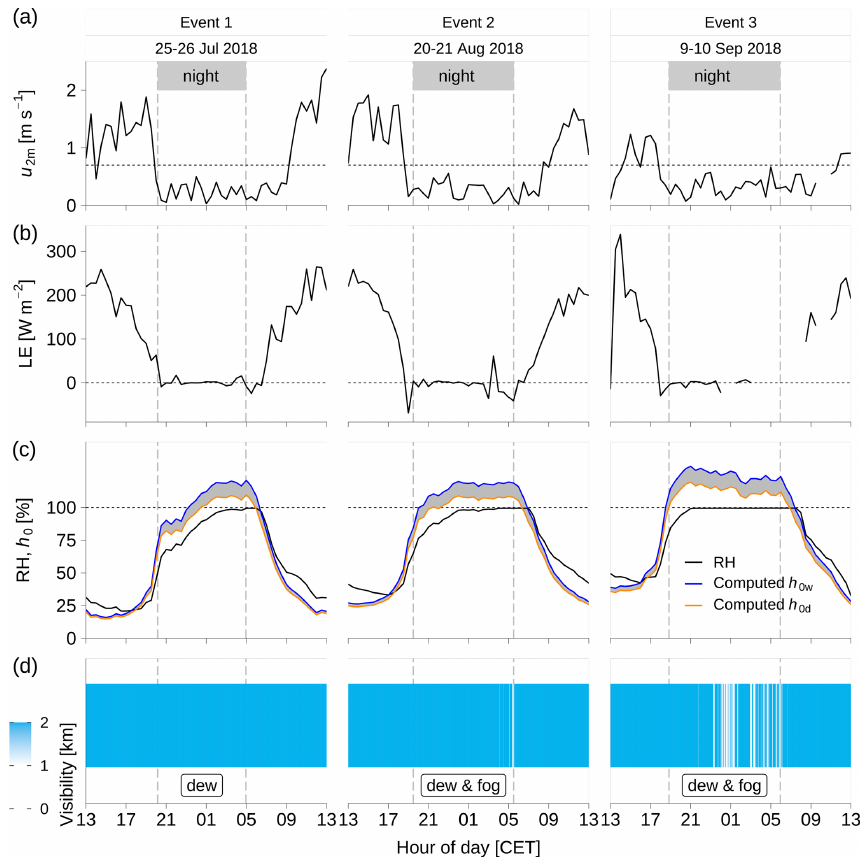
Figure 4. The meteorological and eddy covariance (EC) measurements at the Chamau site. (a) u 2m , mean wind speed at 2ma.g.l.; (b) LE, latent heat flux; (c) RH, relative humidity at 2ma.g.l.; h 0w and h 0d , computed relative humidity with respect to the simulated wet and dry surface temperature; (d) visibility was <1km when fog occurred, and visibility was > 1km with the absence of fog. Panels (a–c) show 30min average data, and panel (d) shows 1min data. Vertical dashed lines show local sunset and sunrise times. The missing values of LE: as soon as fog occurs or dew drips to the optical windows of the open-path infrared gas analyzer (IRGA), LE measurements become unrealistic and cannot be analyzed